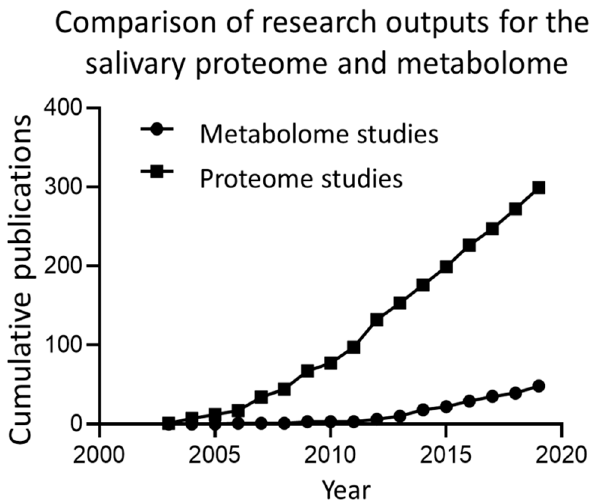
Figure 2. A comparison of research outputs for salivary proteomic and metabolomic studies. Data was gathered by searching Scopus for the terms “saliva” OR “salivary” AND “proteome” OR “proteomics” compared to “saliva” OR “salivary” AND “metabolome” OR “metabolomics” in article title fields.